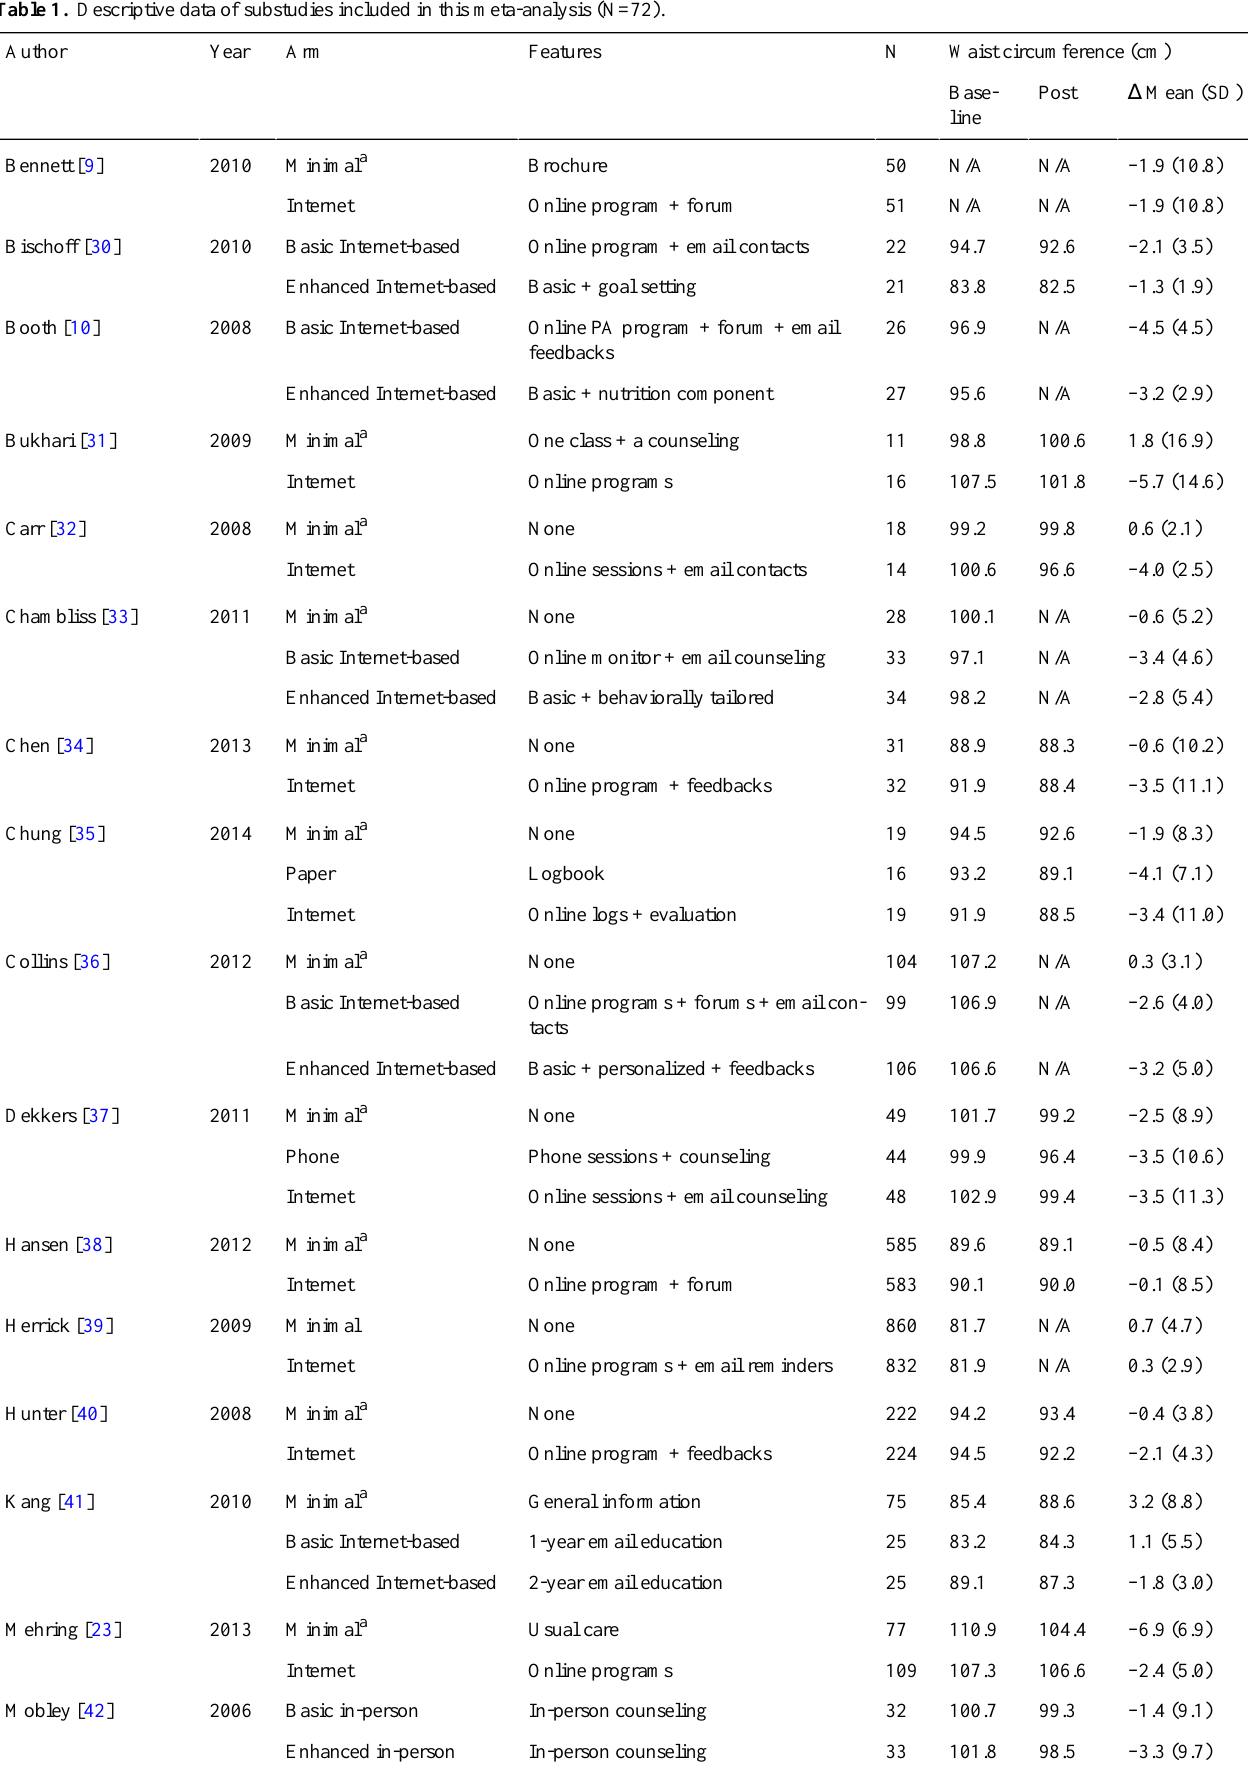
Table 1. Descriptive data of substudies included in this meta-analysis